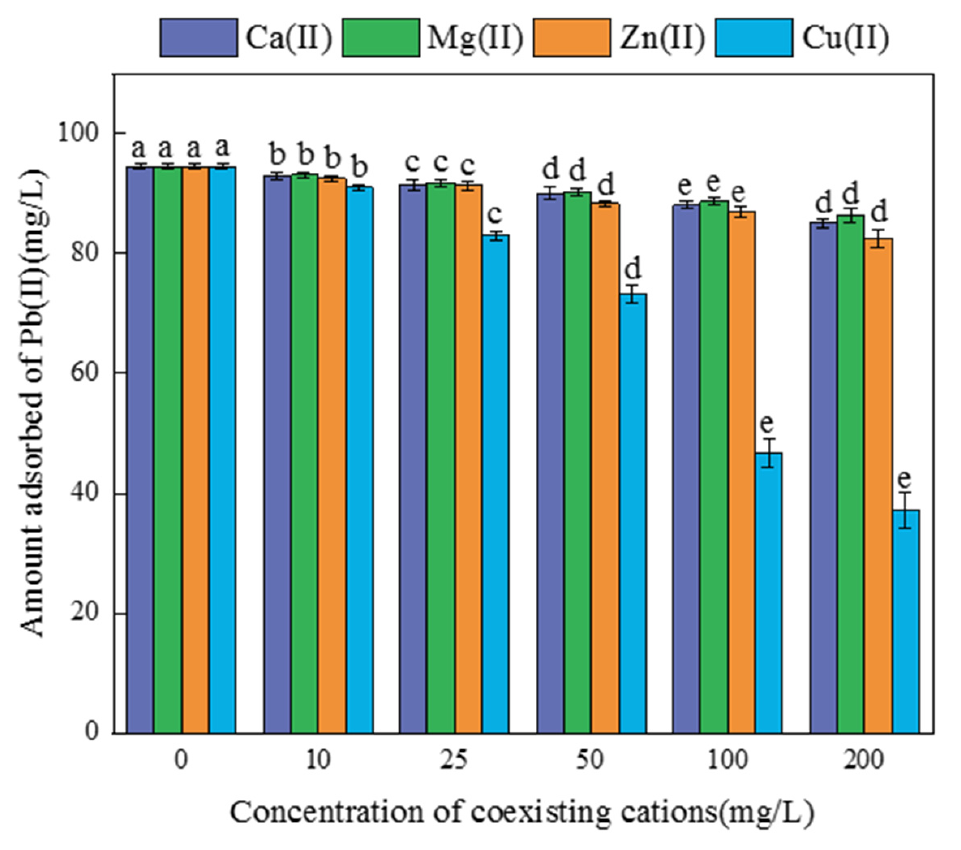
Figure 6. The effect of coexisting ions on Pb(II) adsorption by FM-BC. Different letters indicate significant differences ( p < 0.05).